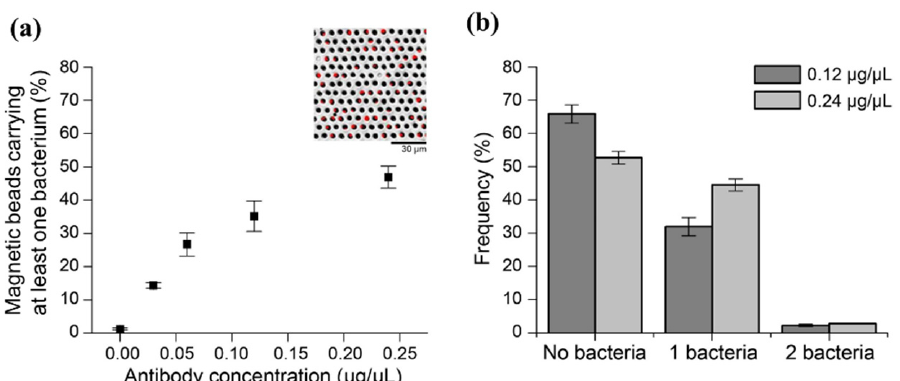
Figure 4. Optimization of immobilized antibody concentration for efficient capture of bacteria on MBs. ( a ) Increase in fraction of MBs carrying at least one bacterium with an increase in antibody concentration can be seen, as analyzed based on fluorescence from mCherry bacteria ( inset ). For each point, a minimum of 11,500 beads were analyzed over three independent repetitions. ( b ) At 0.12 and 0.24 µg/µL of anti- Salmonella antibody concentrations, the number of bacteria captured per MB was determined. Error bars represent standard error of the mean of triplicate measurements.